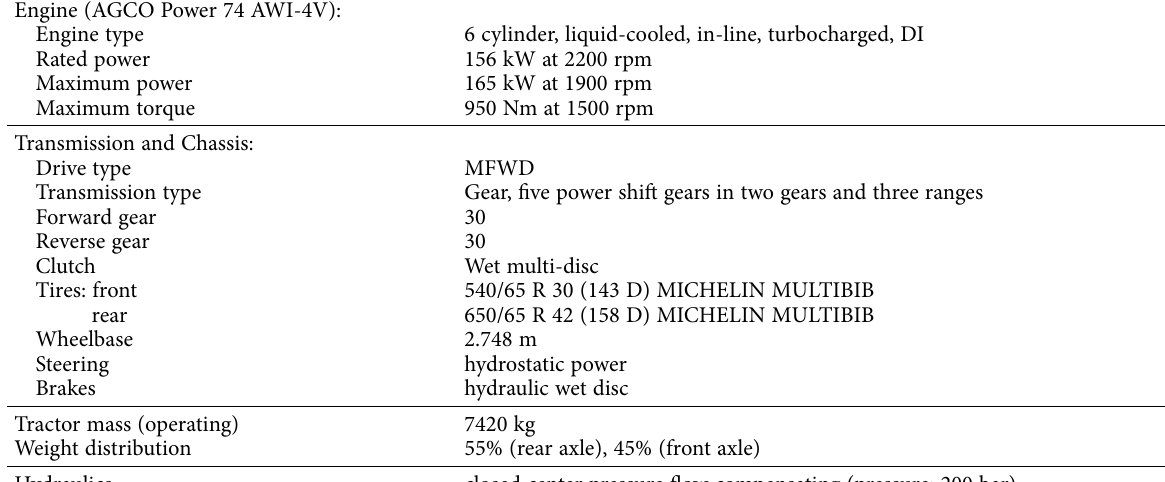
Table 1. Tractor (Valta T-213 VERSU) specifications